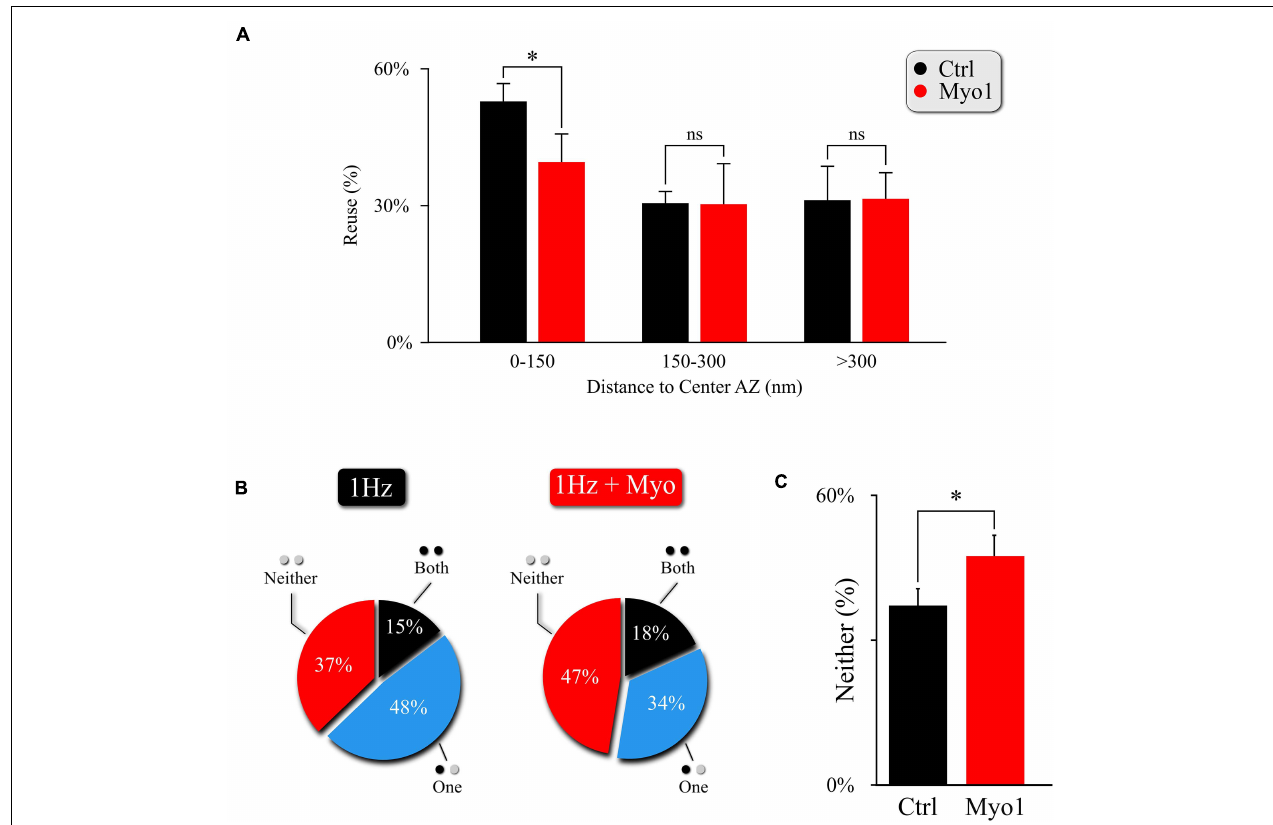
FIGURE 3 | Myosin V regulates utilization of release sites engaged in MVR. (A) Effect of myosin V inhibition with Myo-1 (red) on reuse of release sites engaged in MVR events. Reuse was quantified as the percentage of release sites engaged in MVR that are reused at least once during the 120 s observation period by either other MVR or UVR events. The reuse probability is highly dependent on the distance to AZ center; to account for this variability, we use a paired t -test with data binning at 50 nm. (B,C) Effect of myosin V inhibition with Myo-1 (red) on the spatial overlap of MVR and UVR events determined by the proximity analysis. Percentages of MVR events in which none (red), one (blue), or both (black) events in the pair occurred within ± 25nm of at least one UVR event (i.e., at the same at release site) during the observation period (B) , and quantification of the percentage of no overlap of MVR and UVR events (C) . Two-sample t -test (A) or Barnard’s test (C) . ∗ p < 0.05, ns, not